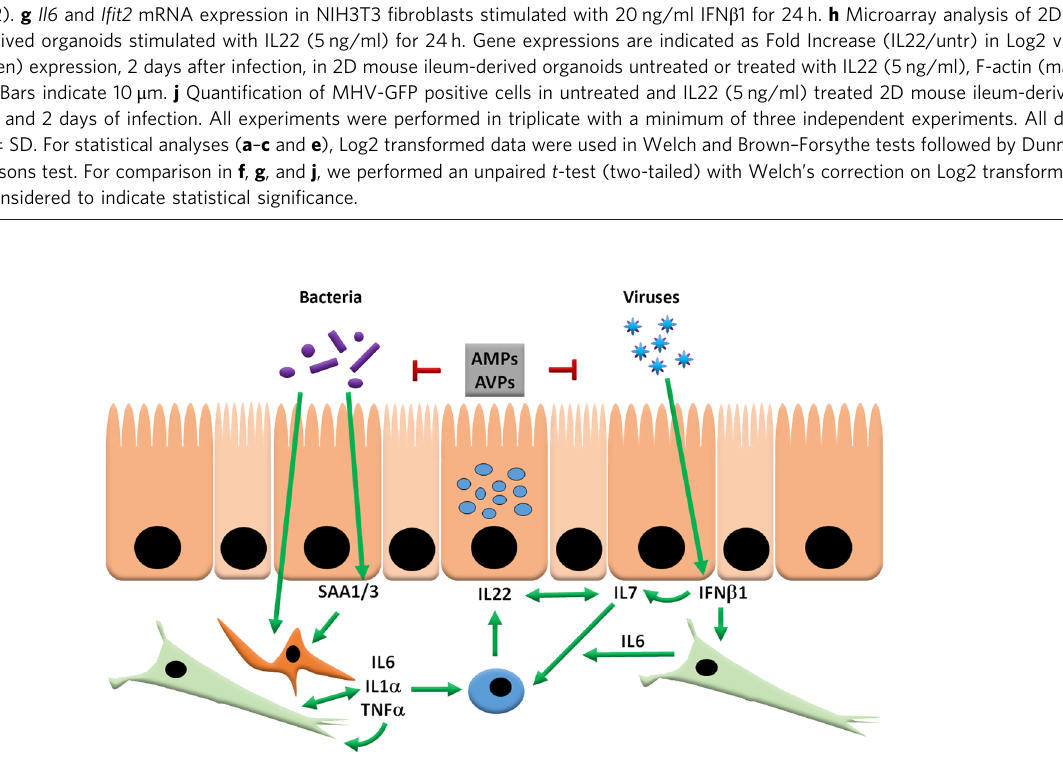
Fig. 8 Model for bacterial and viral induced expression of IL22. Bacterial-derived products, such as LPS and Pam3, can induce SAA1 (humans) or SAA3 (mouse), which can trigger dendritic cells or macrophages to produce IL1 α and in turn, IL1 α can induce the expression of IL6 in fi broblasts. In addition, SAA1 can also induce the expression of IL6 in fi broblasts in the absence of macrophages of dendritic cells. The secreted IL6 can then induce the expression of IL22 in T cells and this expression can be enhanced by IL7, which can be secreted by IEC. Moreover, the secretion of IL7 by IEC, can be enhanced by IL22, resulting in a positive feedback loop for IL22 induction and eventually giving higher expression of Reg3 β and Reg3 γ . Alternatively, LPS can directly activate sampling DCs and macrophages or activate these cells after intestinal damage, resulting in a strong immune response with high induction of IL6, IL1 α , IL1 β , TNF α , and subsequent IL22 induction, in which case TNF α enhances the IL6-induced IL22 production by T cells. A viral pathway involving IFN β 1 can also induce IL22 via IL7 produced by IEC and fi broblast- secreted IL6, after which anti-viral proteins (AVPs) can be induced by